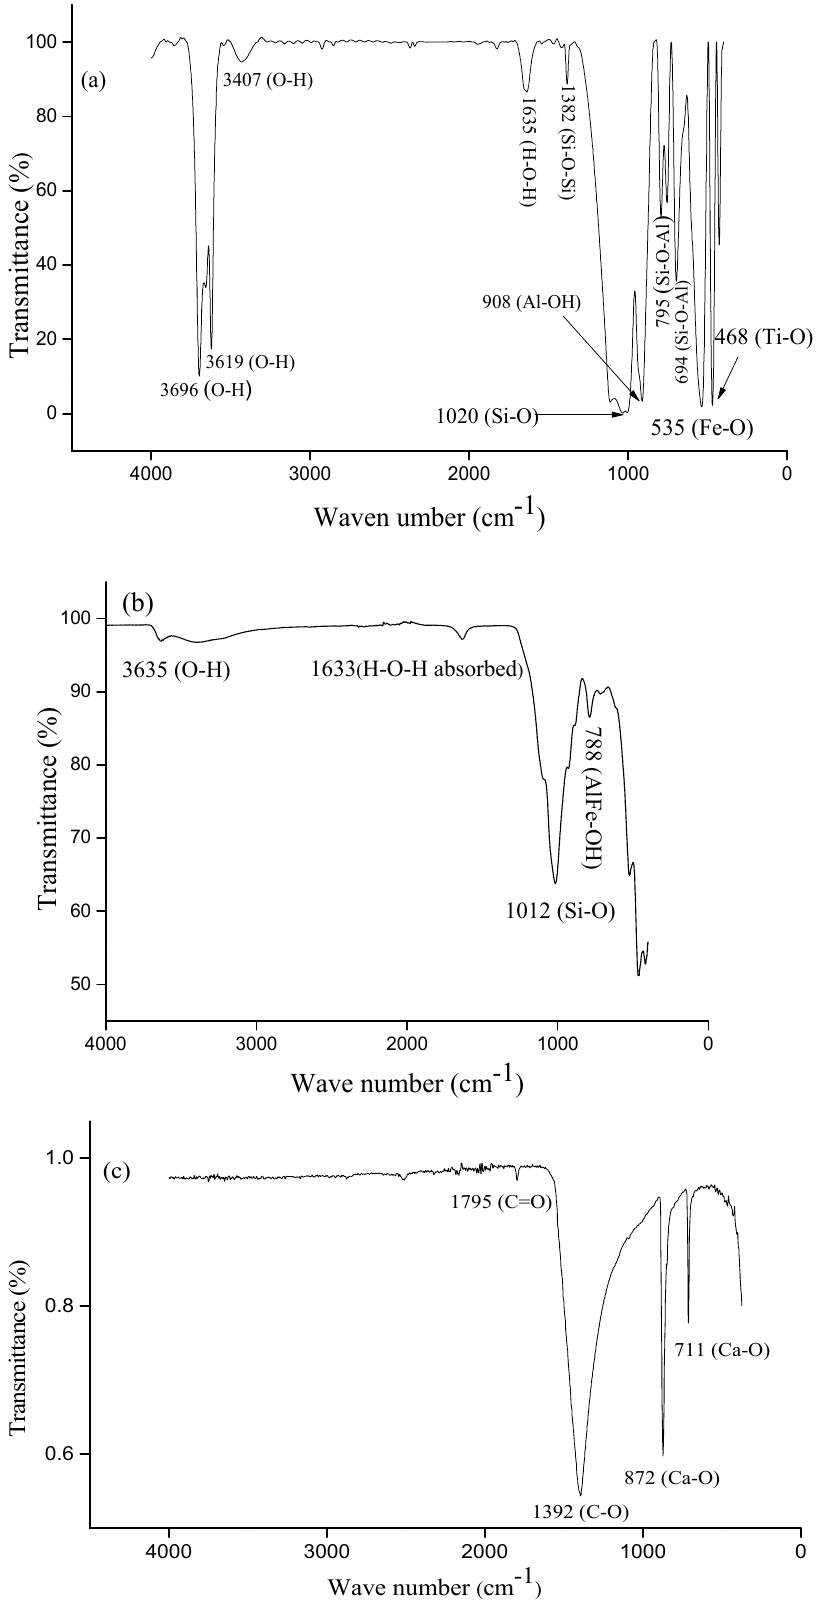
Figure 3. FTIR spectra of kaolin ( a ), bentonite ( b ) and limestone ( c ).